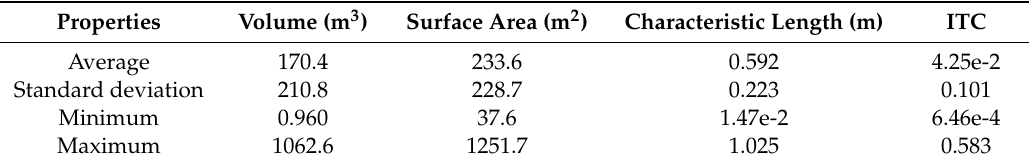
Table 1. Geometric properties of the building geometry